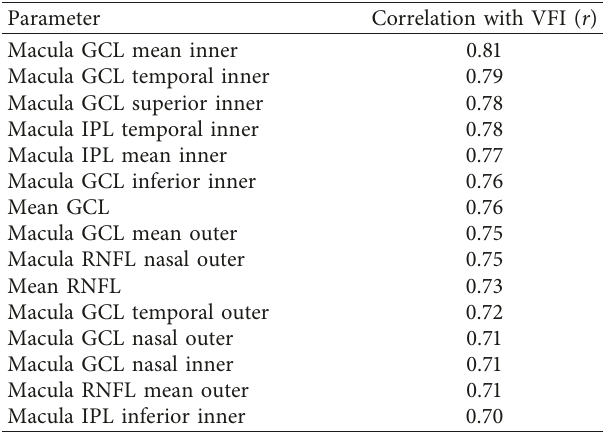
Table 3: Pearson correlation coefficient between VFI and OCT